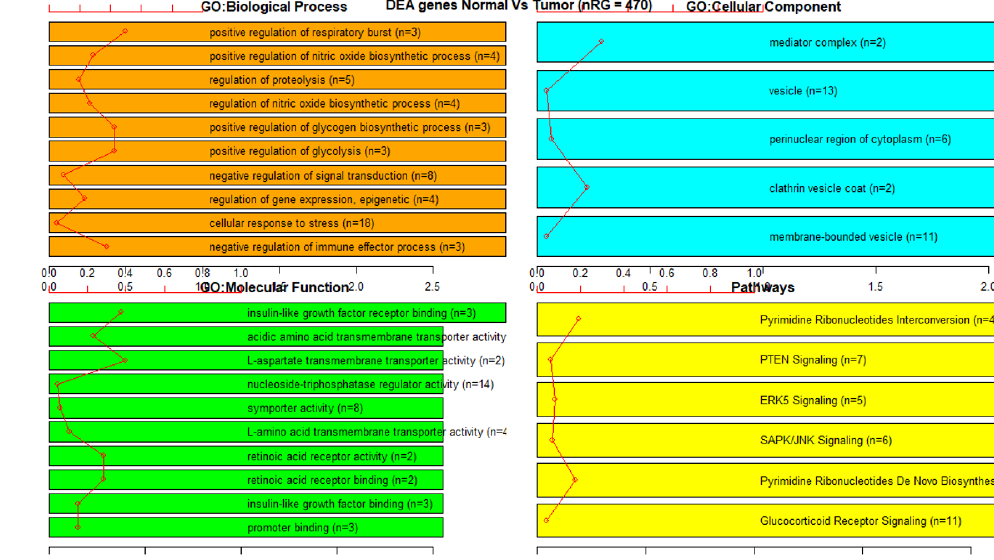
Figure A2. Gene Set Enrichment Analysis on reduced markers of 27K without SMOTE.